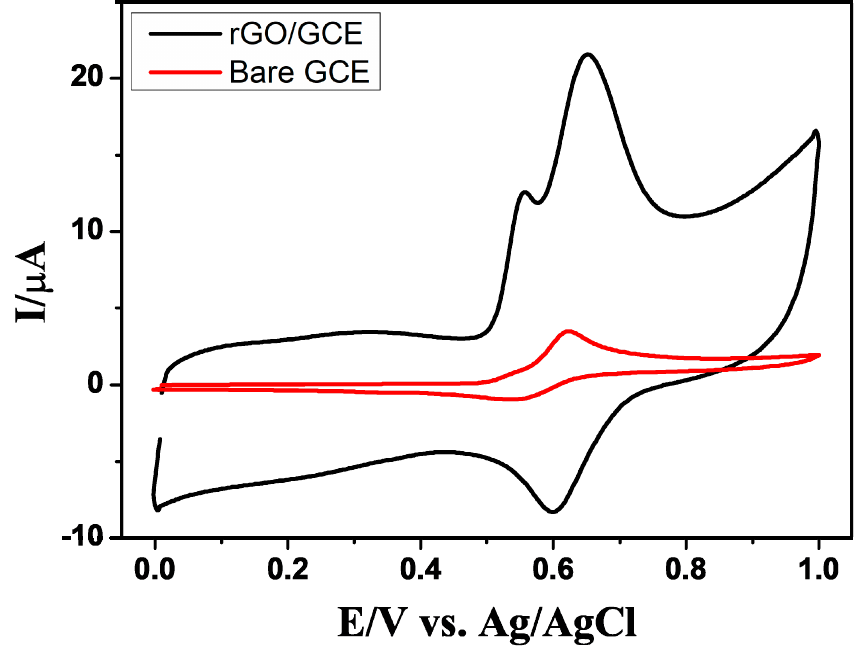
Figure 3. CVs of 0.10 mM GA and 0.10 mM PA in B – R solution (pH 2.1) at a scan rate of 50 mV·s − 1 .